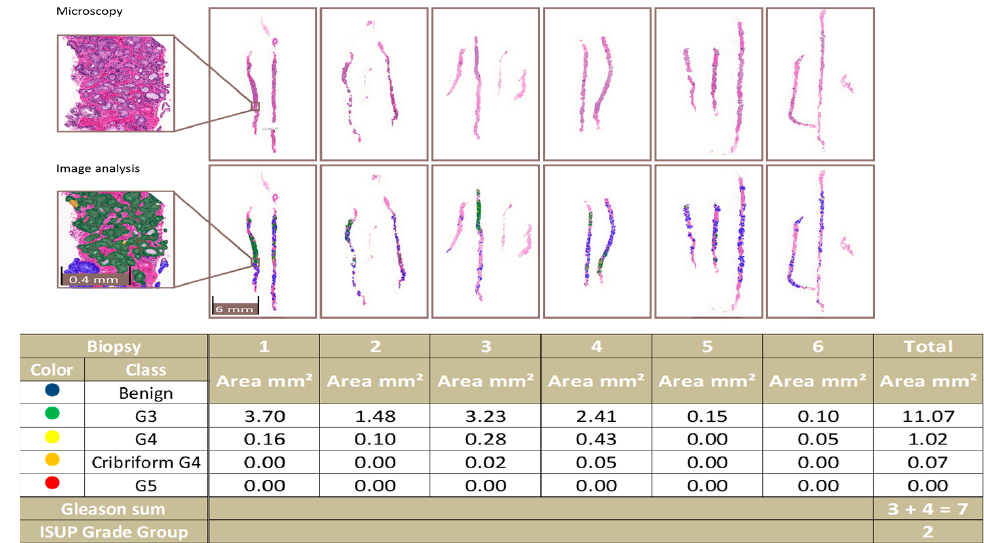
Figure 4. An example of a complete biopsy session slide set. Image analysis data are produced by pixel-level multi-class semantic segmentation at the level of the individual biopsy slide and compiled at the level of the complete slide set. In the example, the patient-level ISUP grade group is 2.